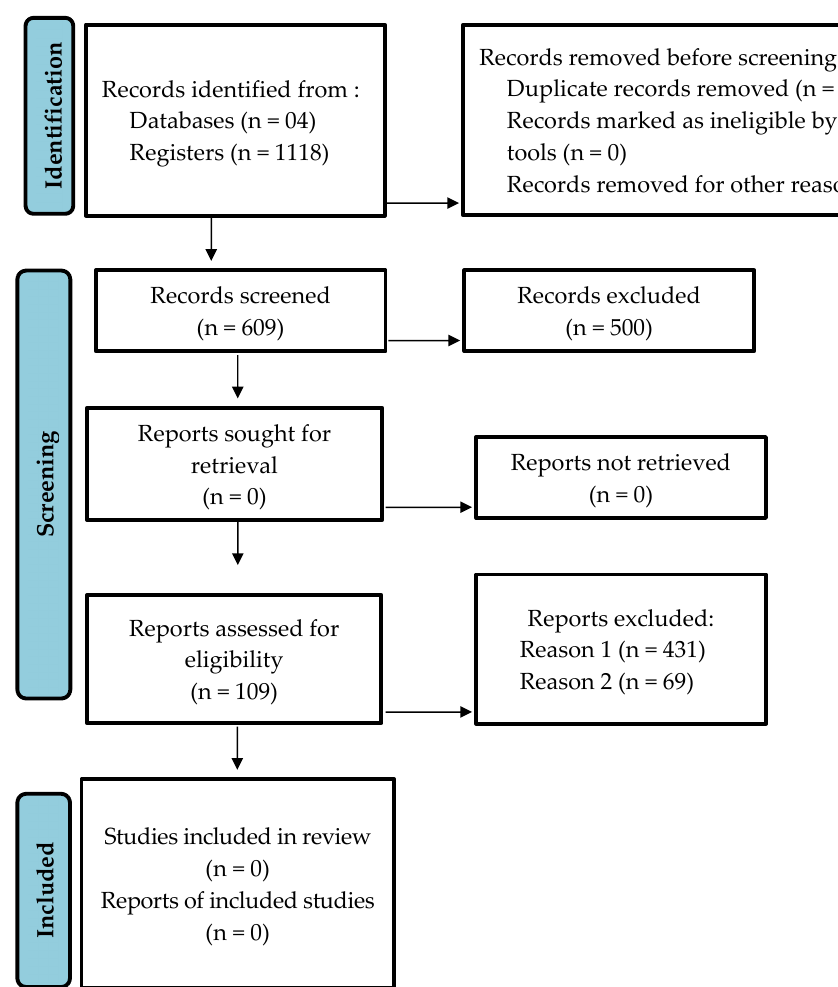
Figure 1. Flowchart with identification and selection of studies related to the molecular mechanisms of interaction between M. perniciosa and its hosts, according to PRISMA guidelines. n: number of studies.